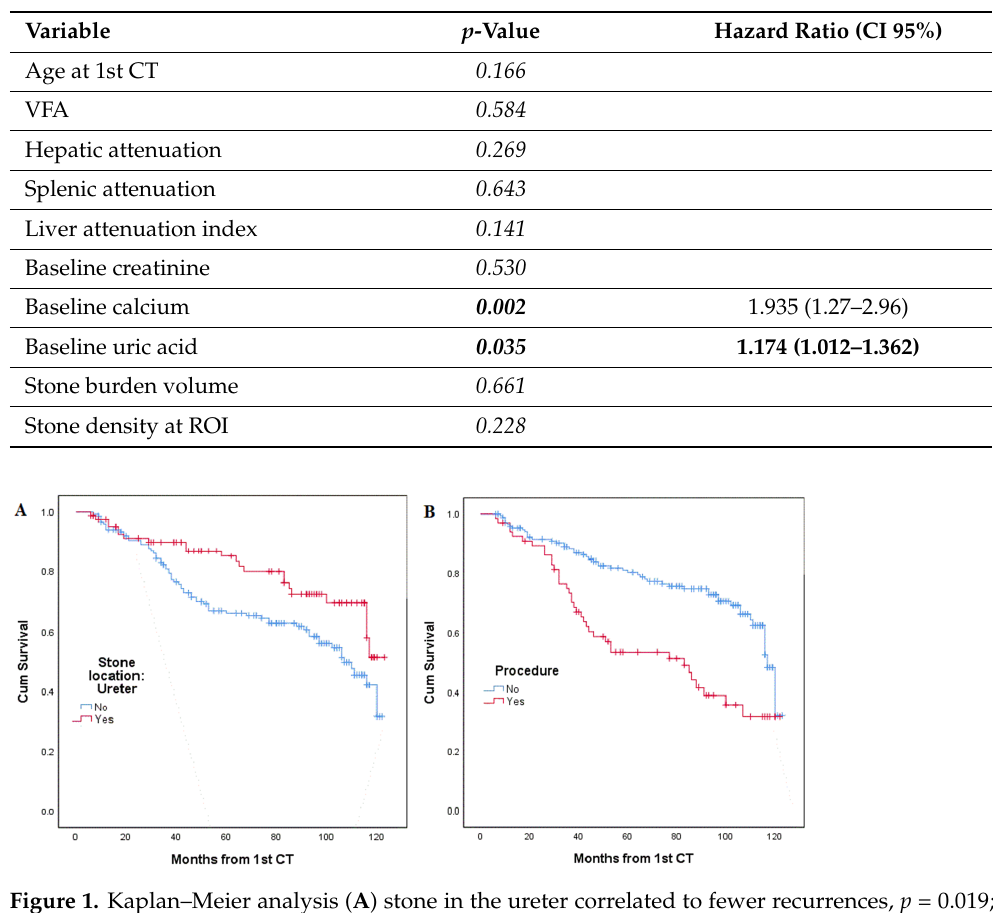
Table 4. Univariate Cox regression survival analysis for continuous variable. Boldface indicates statistically significant factors.